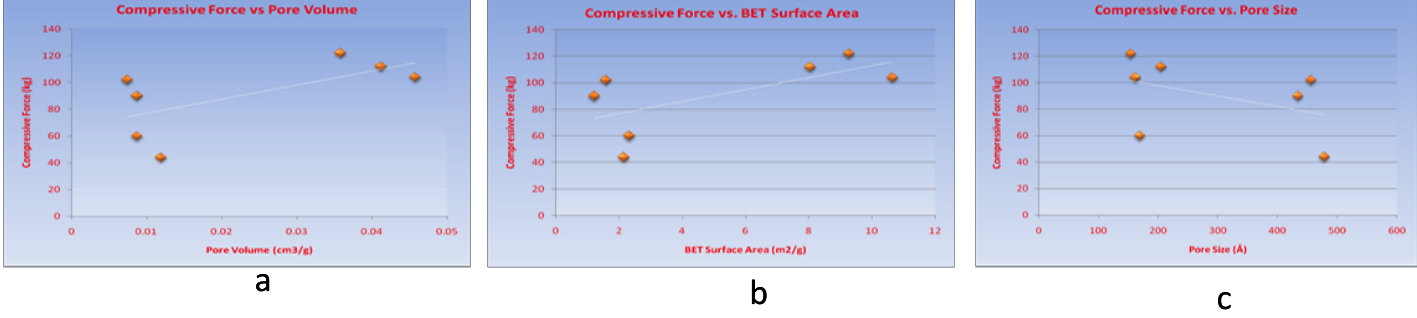
Figure 1 : Best &it line s through intercepts of speci/ic pore characteristics and compressive strength of samples. a,b. Graphs show a slight positive correlation. c. Graph shows a sl ight neg a tive